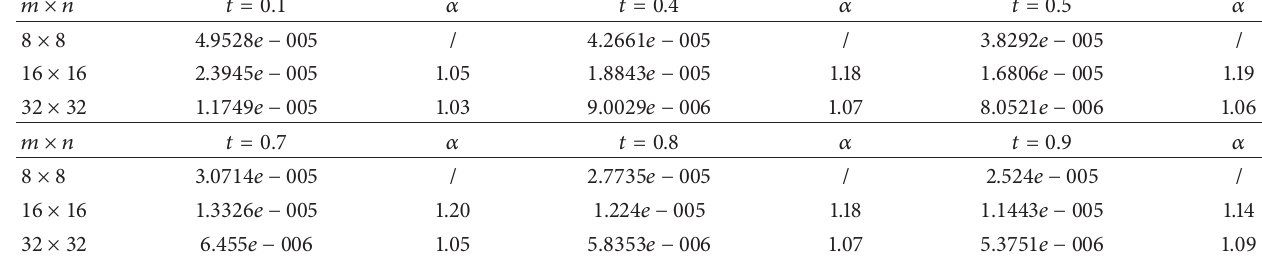
Table 3: Numerical results of ‖𝜎 − 𝜎 ℎ ‖ .